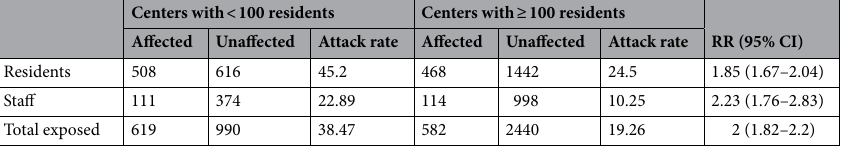
Table 1. Attack rates and rate ratio (RR) according to the capacity of the facility (separately for residents and staff and globally).